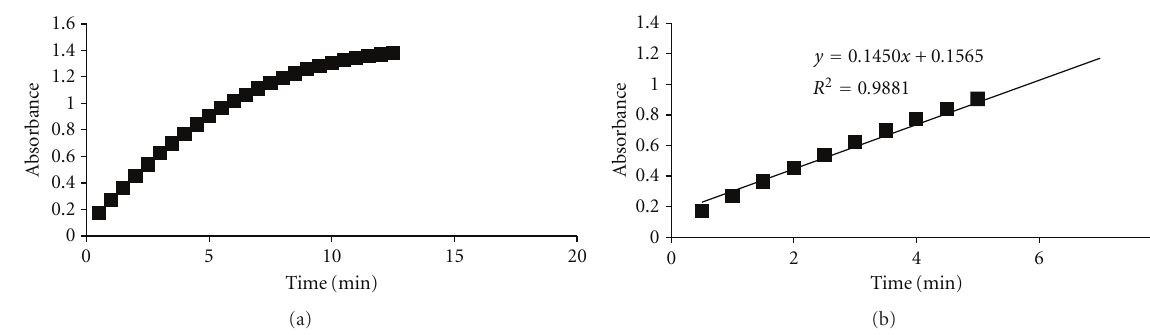
Figure 5: Activity of DLBS1033 on chromozym substrate. (a) Change in the absorbance at 405nm during assay of DLBS1033 with chromozyme. (b) Linear section of changes in absorbance per one minute.